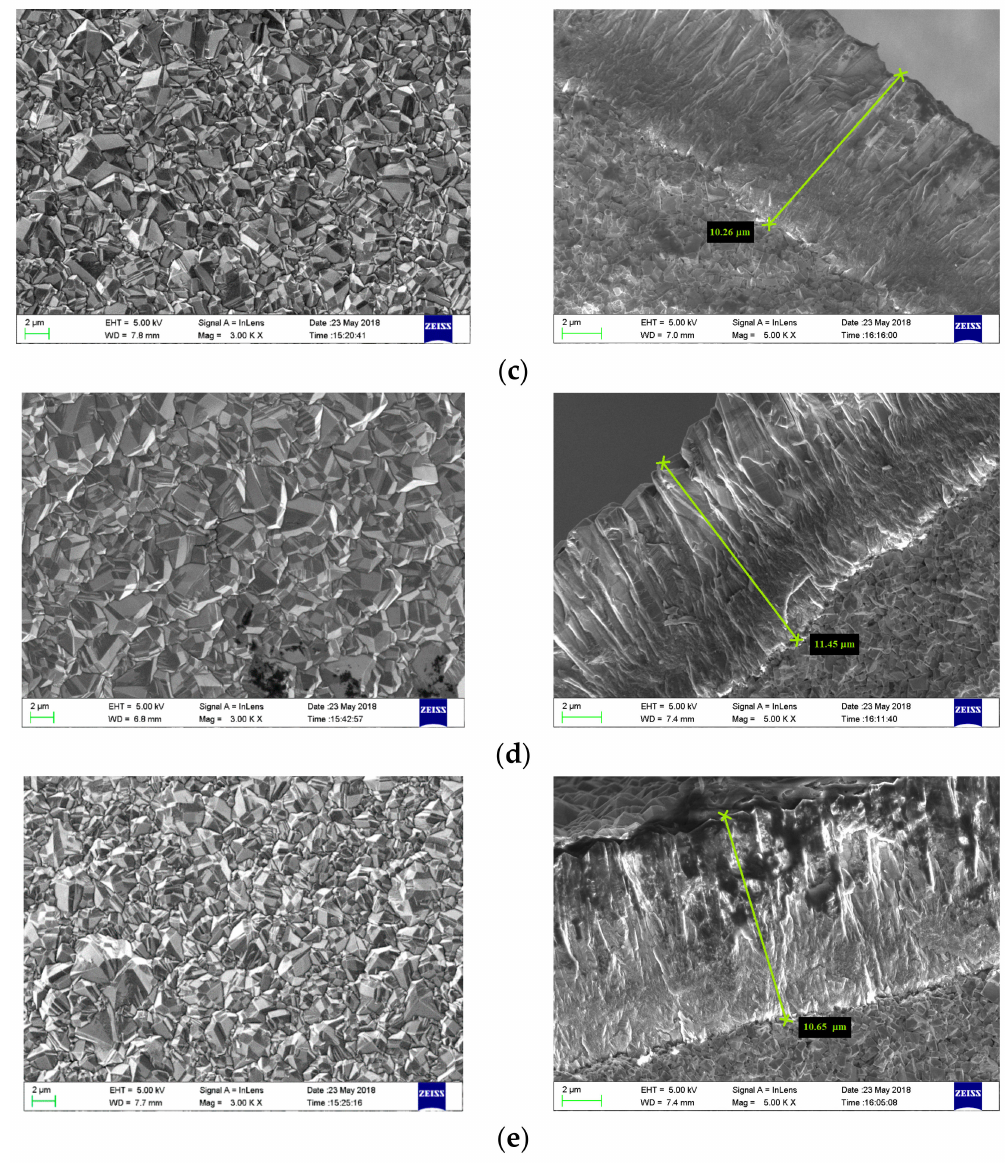
Figure 6. FESEM images of mills at di ff erent locations. ( a ) a representative coated tool; ( b ) Position A of No. 13 milling cutter; ( c ) Position B of No. 13 milling cutter; ( d ) Position A of No. 1 milling cutter; ( e ) Position B of No. 1 milling